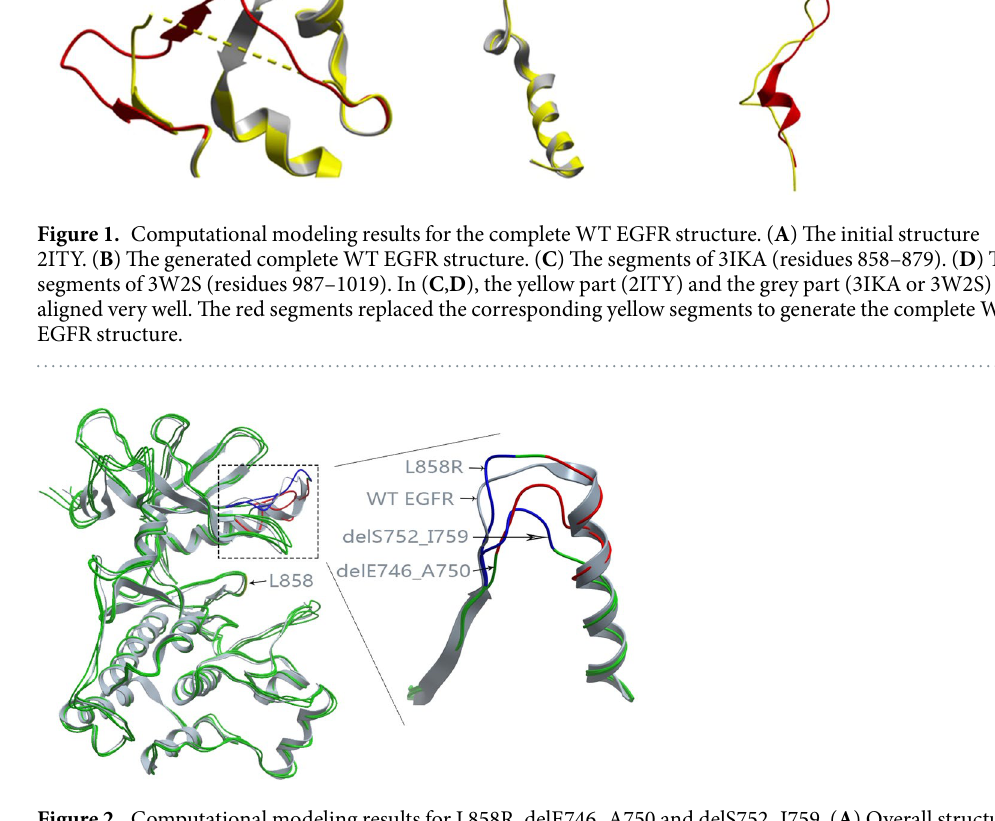
Figure 2. Computational modeling results for L858R, delE746_A750 and delS752_I759. ( A ) Overall structures for these three mutants. ( B ) Details in the deletion sites. Blue parts are the sites of E746 to A750 and red parts are the sites of S752 to